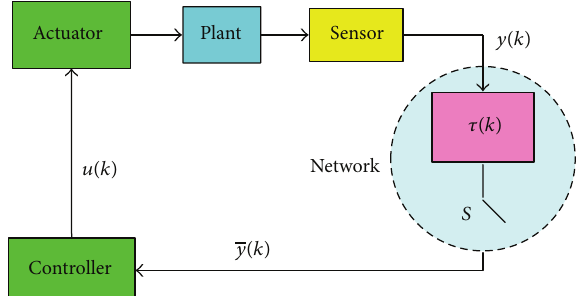
Figure 1: The structure of the NCS with random delays and/or packet